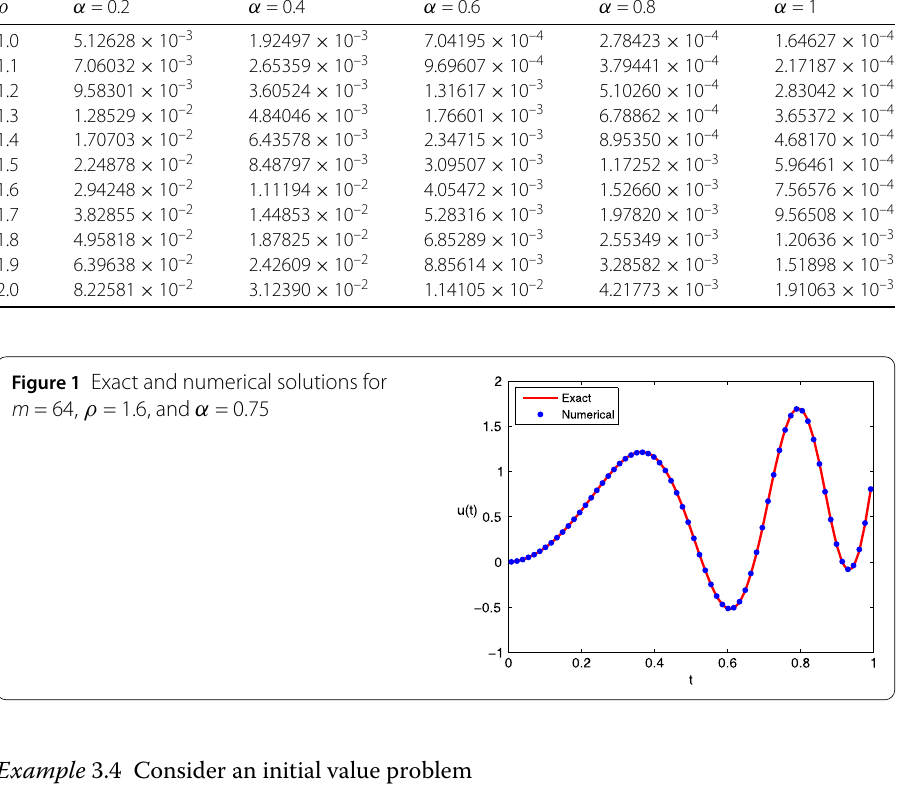
Table 1 Maximum absolute error for distinct values of ρ , α , and m = 64